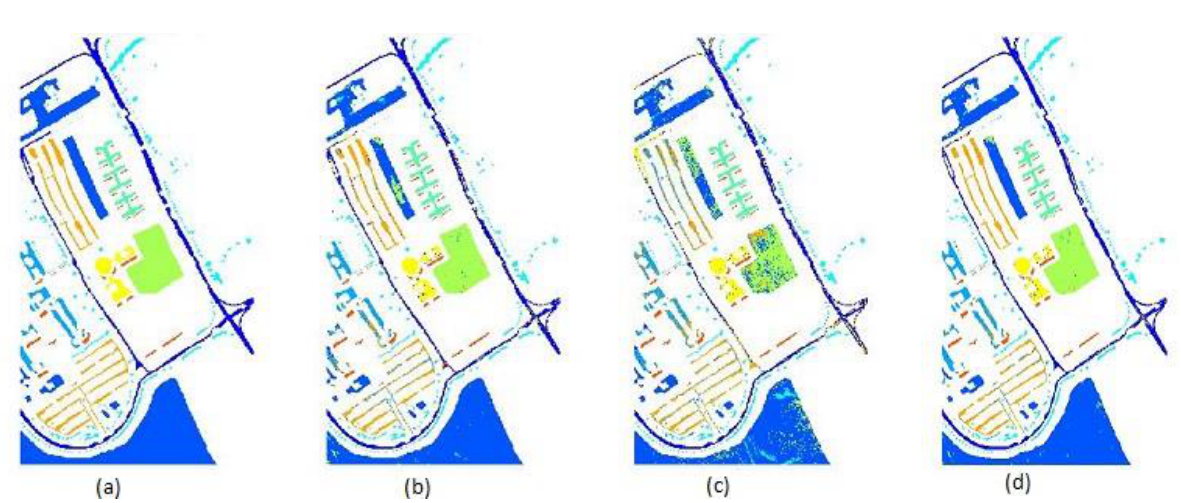
Figure 4. Classification map for the University of Pavia dataset. (a) Reference map, (b) Spatial proposed method, (c) spectral, (d)